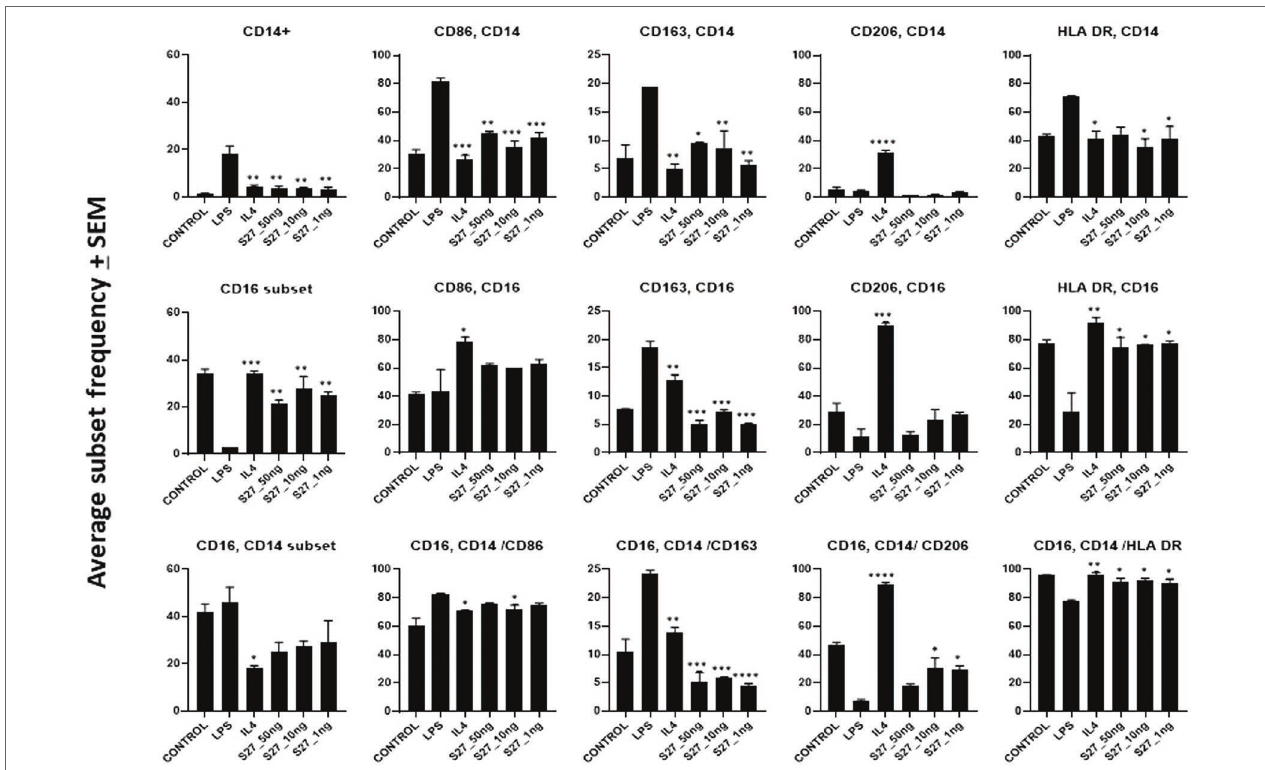
FIGURE 6 | Flow cytometry analysis of PBMM treated with LPS and IL-4 positive controls, and S27 at 1, 10, and 50 ng compared to untreated control. Phenotypic profiling of macrophages following treatment with secreted peptides was examined by assessing the differential expression of key macrophage-related markers including CD14, CD16, CD86, CD163, and CD206. The results were analyzed using one-way ANOVA and presented as mean ± SEM. * p < 0.05, ** p < 0.01, *** p < 0.001, and **** p < 0.0001, which is significantly different from another